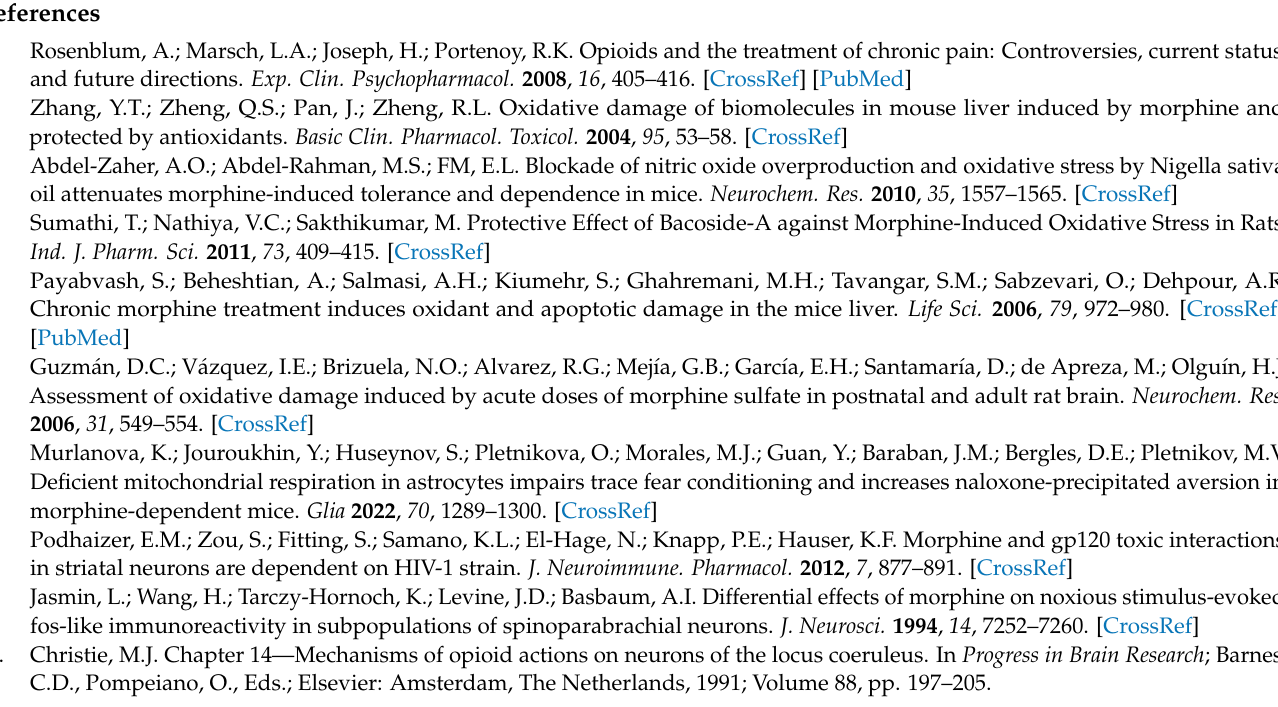
proteins quantified and DEPs output, Table S2: Top 5 GO enrichment for EVs, Table S3: HBMECs proteins quantified and DEPs output and Table S4: Top 5 enrichment pathways analysis of HBMECs and EVs treated by morphine. Supplementary File S1: Metabolomic